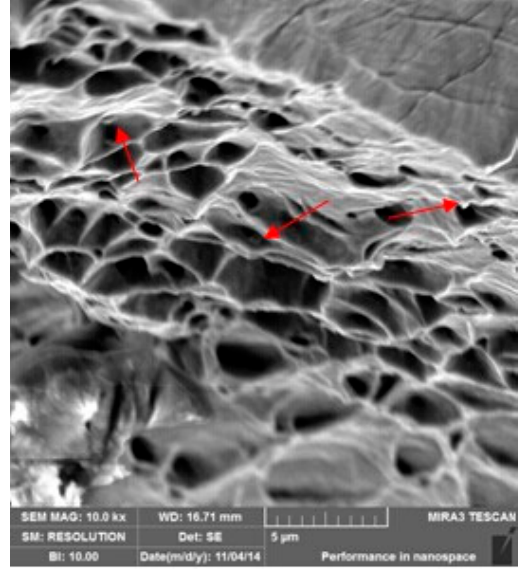
Figure 12. The fracture morphology of the typical weld sample.